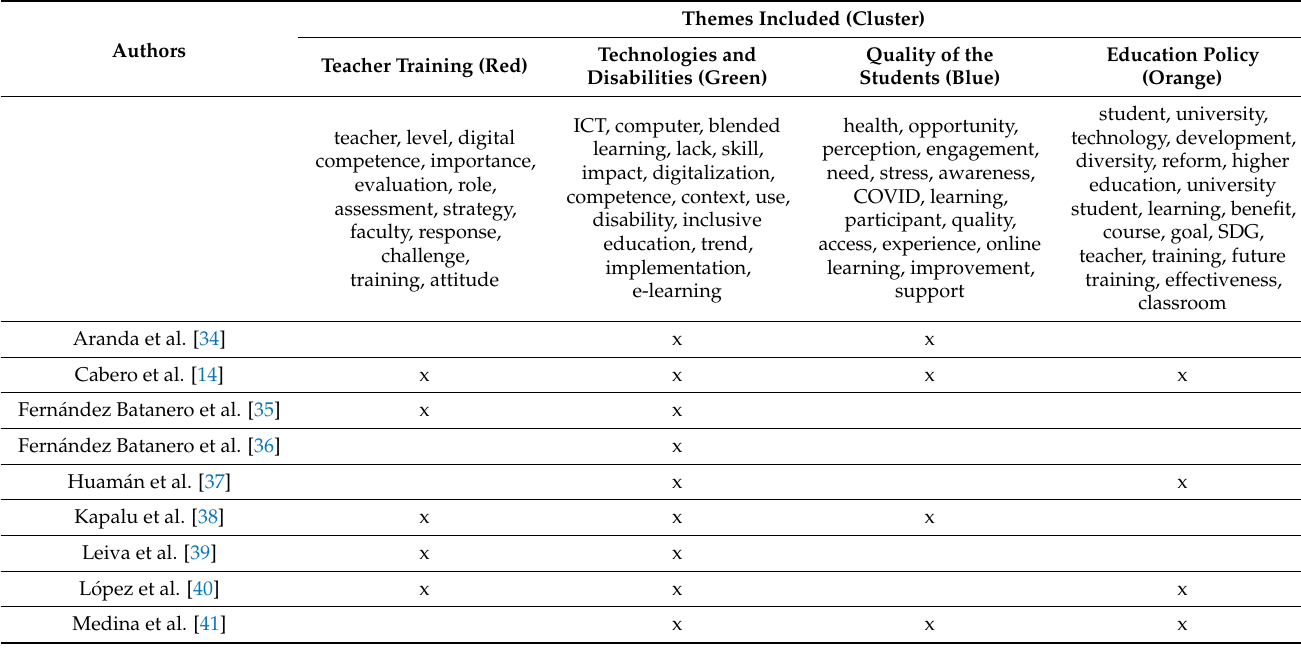
Figure 5. Keyword co-occurrence map. Each node in the network represents a keyword, the size indicating the number of times it is repeated [47]. Each colour represents a thematic group (cluster). In this study, a total of 65 keywords were retrieved and grouped into 4 clusters (red, green, blue, and orange) to identify the key themes of the research. Table 2 lists the keywords included in each cluster, as well as the themes related to each of the studies analysed. Table 2. Description of the keywords included (clusters) and related topics in each